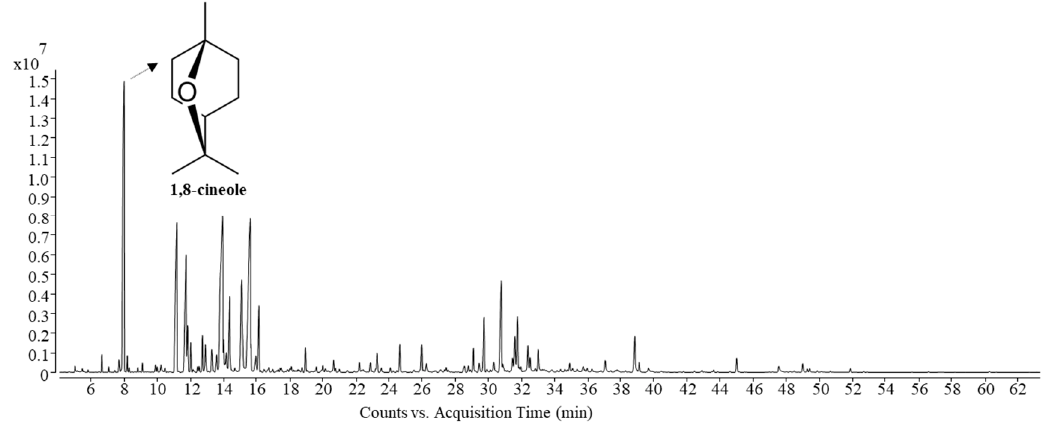
Figure 3. Total ion compound (TIC) chromatograms of the Siam cardamom essential oil obtained via MA-SDE. Table 2. Identified compositions of essential oil from Siam cardamom by GC–MS analysis.